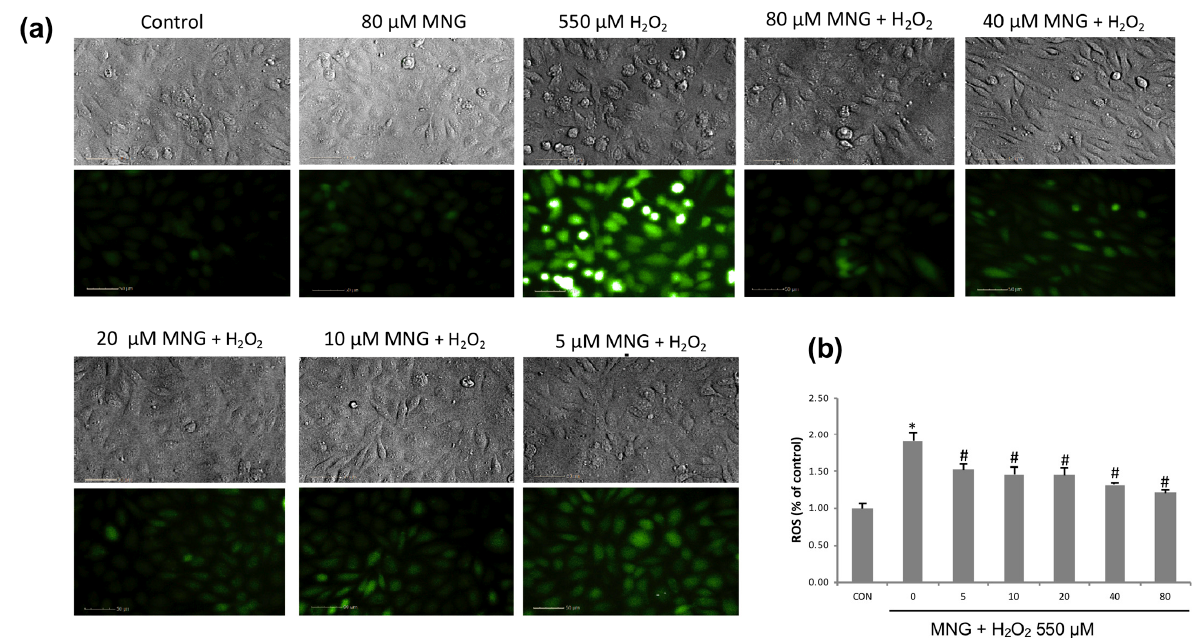
Figure 6. MNG reduced the intracellular ROS generation in EA.hy926 cells. ( a ) Representative images of ROS in EA.hy926 cells were detected by DCFH-DA using the Operetta high content image: vehicle-treated control cells; cells only treated with 80 μ M MNG; cells were treated with 0, 5, 10, 20, 40 or 80 μ M MNG for 24 h followed by exposure to 550 μ M H 2 O 2 for another 6 h (Scale bars represent 50 μ m). ( b ) The levels of intracellular ROS were detected by DCFH-DA using a fluorescence microplate reader. EA.hy926 cells were pretreated with MNG for 24 h at the indicated doses (0, 5, 10, 20, 40 and 80 μ M) before treatment with 550 μ M H 2 O 2 for 6 h and then incubated with 10 μ M DCFH-DA for 30 min. * p < 0.05 vs. control group, # p < 0.05 vs. 550 μ M H 2 O 2 group. Data are the means ± SEM of 3 independent experiments.